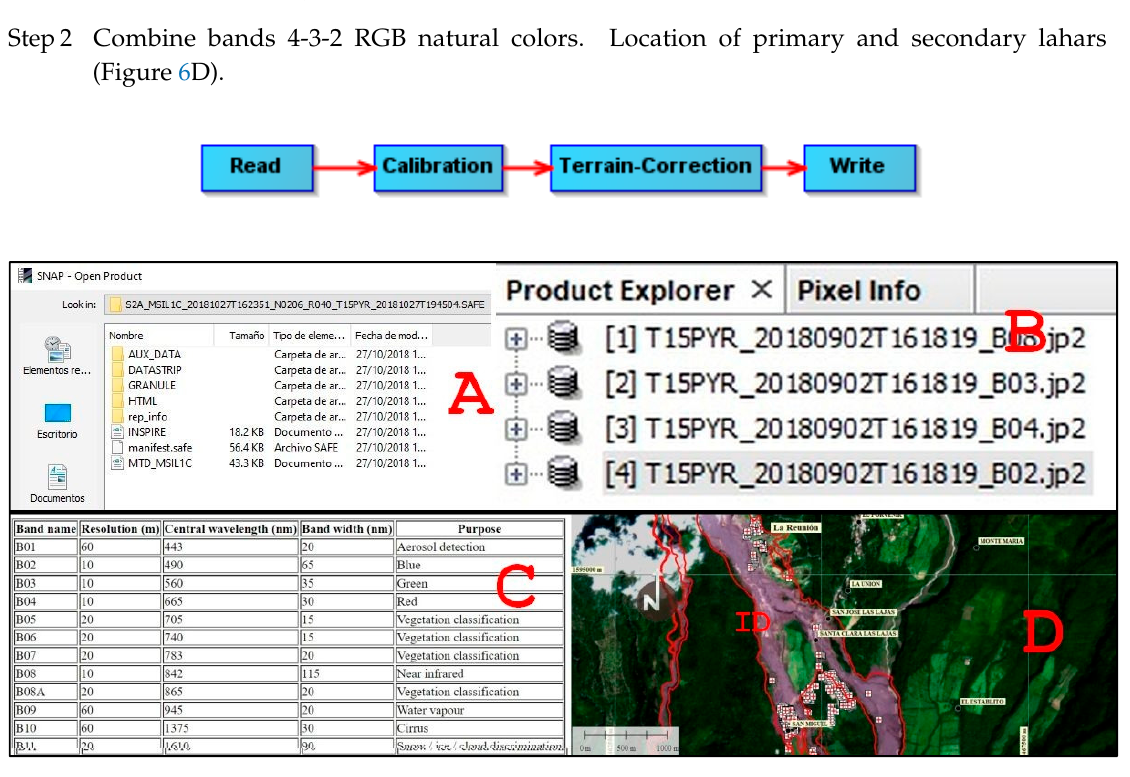
Figure 6. Process flow in SNAP. Spatial location of primary and secondary lahars from a Sentinel image 2. Combination of bands 4, 3 and 2. ( A – C ) SNAP passages of each portion of the routine in Sentinel 2A images. Location of primary and secondary lahars, ( D ) Synthesis of final product: limit of the model of lahar in red color obtained from LAHAR Z. In lead color the location to that date of the real lahar product of the eruption of June 3 and nearby places.